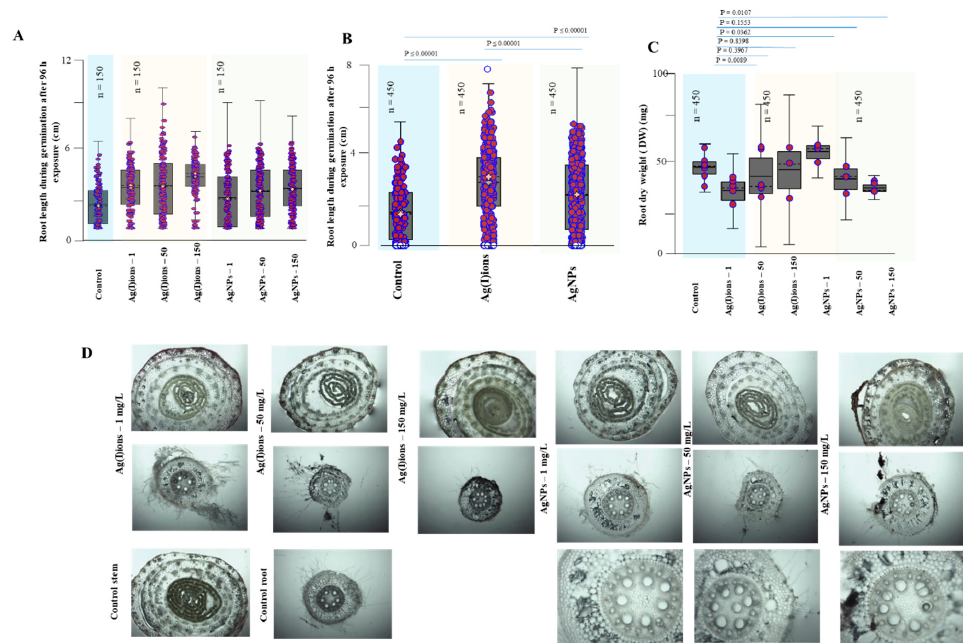
Figure 8. Effect of Ag(I) ions and AgNPs on the root system of germinal plants. ( A ) Root length after 96 h exposure expressed as summary data for each test concentration. ( B ) Summary data for each test group. ( C ) The root dry weight (DW) for each test concentration. ( D ) Changes in the anatomical structure of the stem and root of germinated plants exposed to Ag(I) ions and AgNPs. Plants were collected after 96 h of exposure to hydroponics. Plants were collected in triplicate every day and then processed according to the procedure described in the Material and Methods section. Nanomaterials 2019 , 9 , x FOR PEER REVIEW